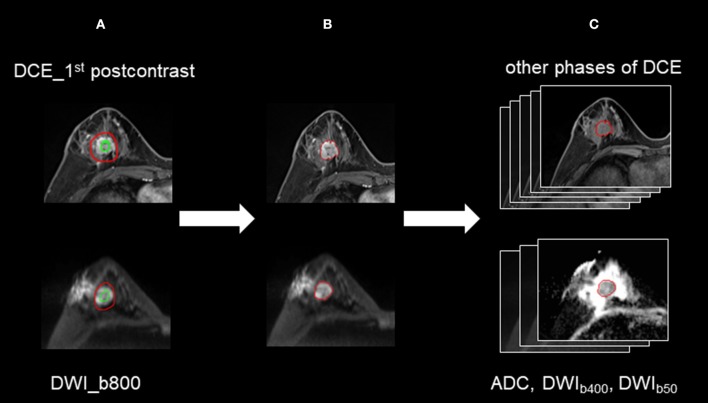
The process for 3D segmentation. The segmentation process comprised three steps: (A) The foreground and background seed points were manually drawn inside and outside the tumor on the DWI images with a b-value of 800 s/mm2 (DWIb800) and the first postcontrast of the DCE images, respectively. (B) The whole-tumor segmentations on DWIb800 and the first postcontrast of the DCE images were executed with a semiautomatic algorithm. (C) For DWI, 3D segmented contouring that was created on DWIb800 was propagated to the DWI images with other b-values. For DCE, 3D segmented contouring that was created on the first postcontrast images was propagated to the precontrast and four postcontrast phases of the DCE images.